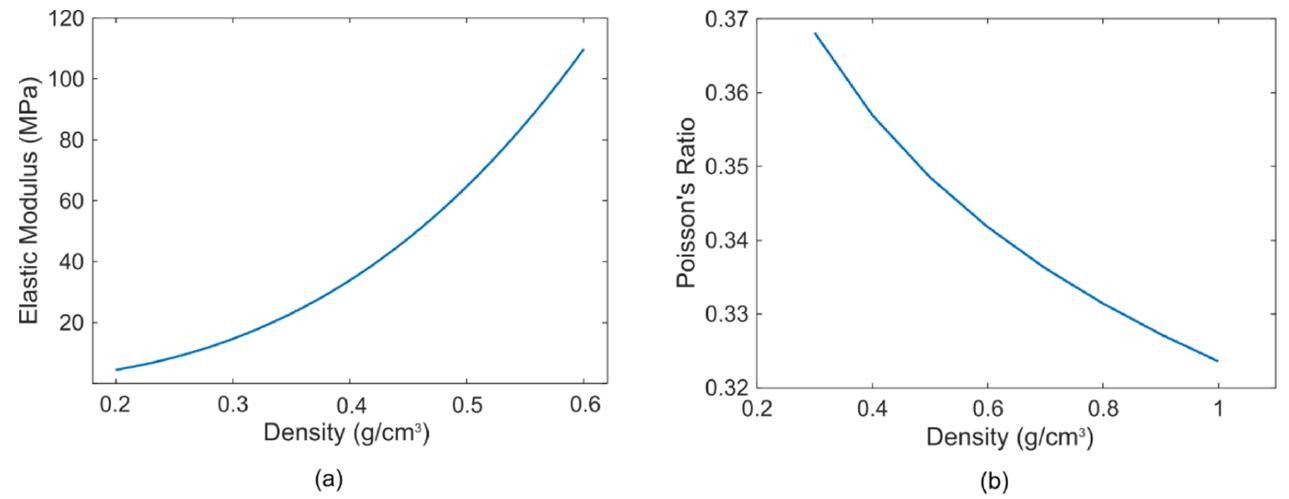
Figure 2. ( a ) Variation of elastic modulus with density, ( b ) Variation of Poisson’s ratio with density [21]. The calculated longitudinal and transverse attenuation coefficients